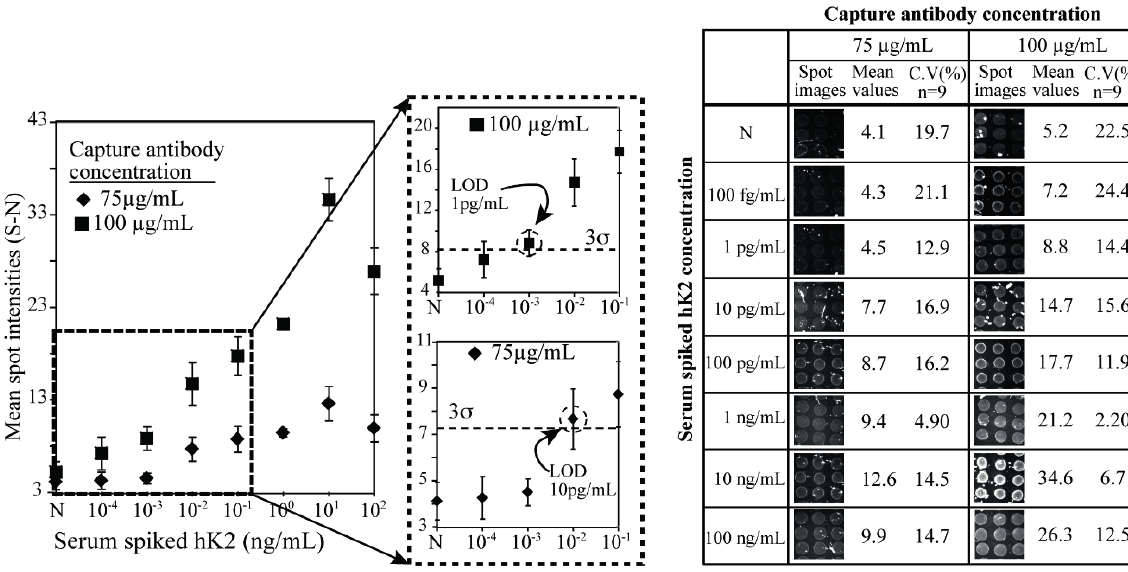
Figure 4. hK2-spiked human female serum analyzed with the sandwich microarray at two different capturing antibody concentrations (75 µg/mL and 100 µg/mL). The LOD was 10 pg/mL and 1 pg/mL when the concentrations of capture antibody were 75 µg/mL and 100 µg/mL, respectively. Increased assay sensitivity was observed with an elevated concentration of the capturing antibody (6B7). The negative signal also increased at the higher concentrations of the capture